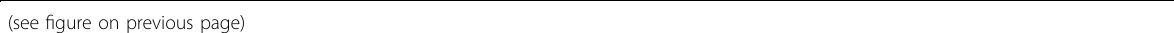
Fig. 6 Effects of rINGAP on Jak2/Stat1/Stat3 phosphorylation in RINm5F treated with cytokines IL-1 β , IFN γ individually, and in combination. RINm5F cells were pre-treated with 1 nM rINGAP for 2 h and then exposed to 100 pg/mL IL-1 β , 1 ng/mL IFN γ , or a cocktail of both for 1 or 6 h. Equal amounts of protein were resolved on stain-free SDS-PAGE and Western blot analysis was used to assess changes in phosphorylation of Jak2, Stat1, and Stat3. A Shown are representative blots from three independent experiments and B – D densitometric analysis presented as relative